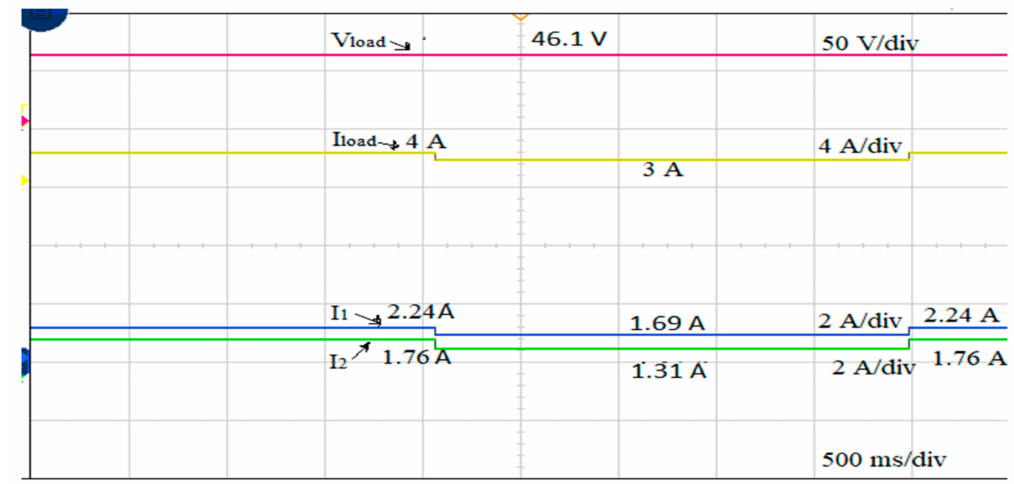
Figure 17. Experimental results for variation in load with different cable resistances for the novel droop control.